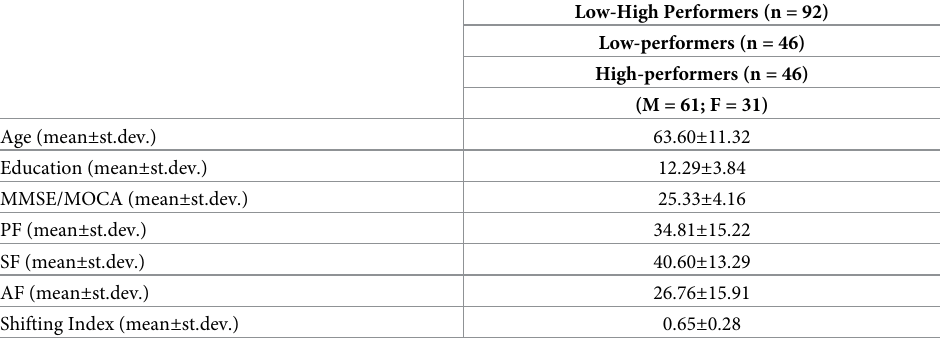
Table 2. Demographic characteristics and performance on the administered tests for the Low-AF and High-AF performers.